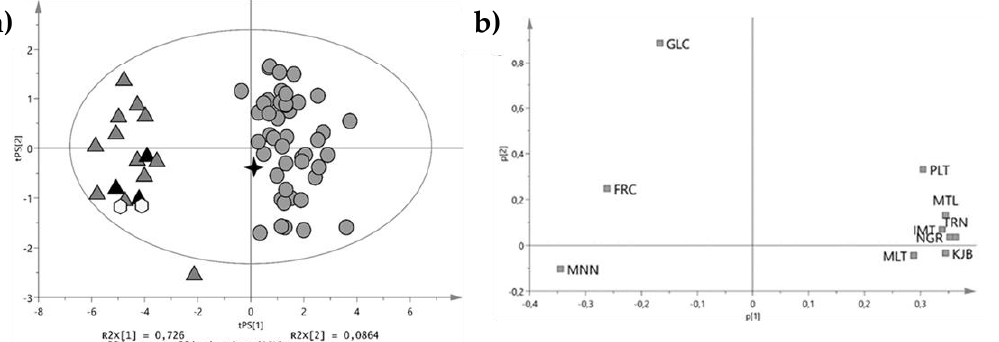
Figure 5. ( a ) Score plot of PCA performed on the sugars matrix. Sucrose and erlose were not considered in this analysis because of their large concentration variability. PC1 and PC2 accounts for 81% of the total variance (i.e., 72.6% + 8.64%). Grey circles: European honey; grey triangles: commercial Chinese honey; black triangles: Chinese honey analyzed with SCIRA; black star: Chinese honey purchased in China; white hexagons: honey from bee-feeding experiments. ( b ) Loading plot that highlights the metabolites responsible for the cluster separation (Reprinted from [32], with permission from Elsevier, Copyright